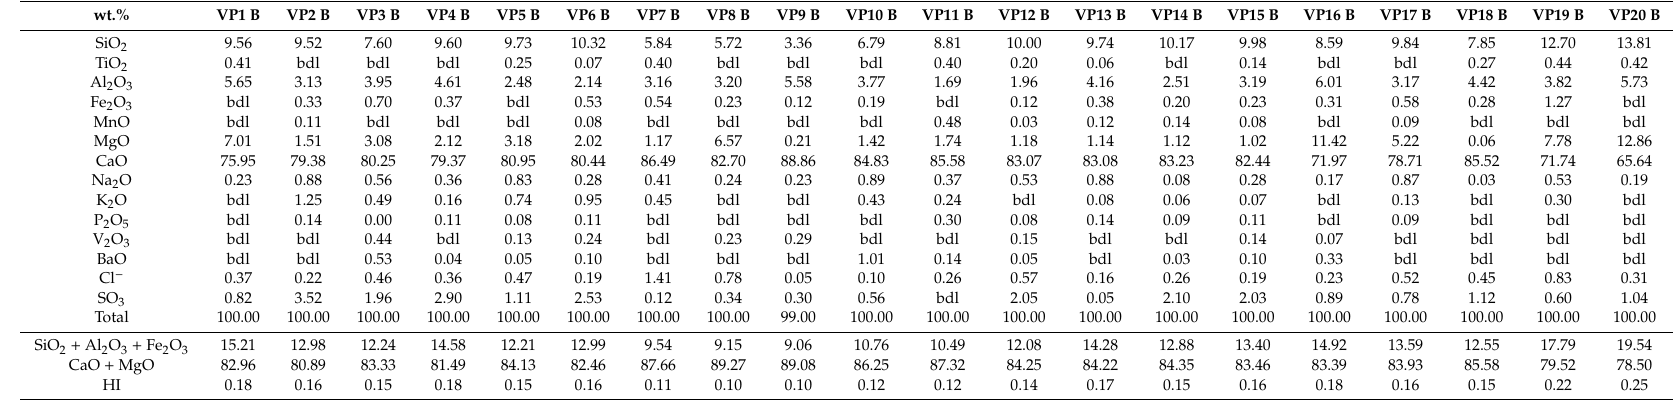
Table 5. Major element concentrations of binder (B) in Villa del Pezzolo mortars (in wt.%; recalculated to 100%; bdl: below detection limits). SiO 2 + Al 2 O 3 + Fe 2 O 3 , CaO + MgO, HI (Hydraulic Index) are also shown.